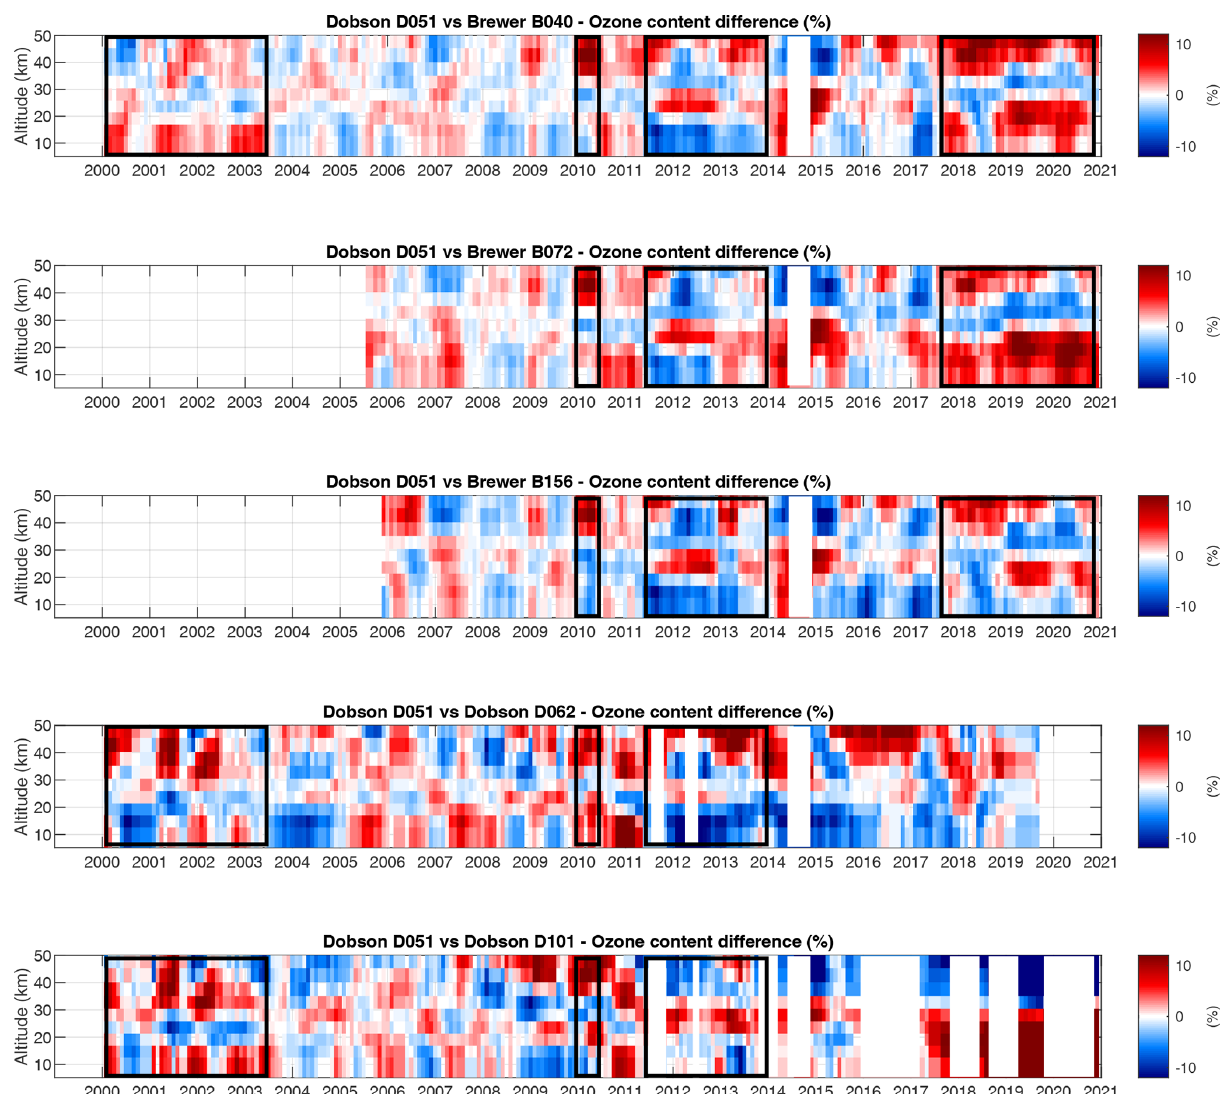
Figure 2. Monthly mean time series of the ozone profiles relative differences for each of the five spectrophotometers with respect to D051. The time series are deseasonalized and smoothed by a 6-month moving